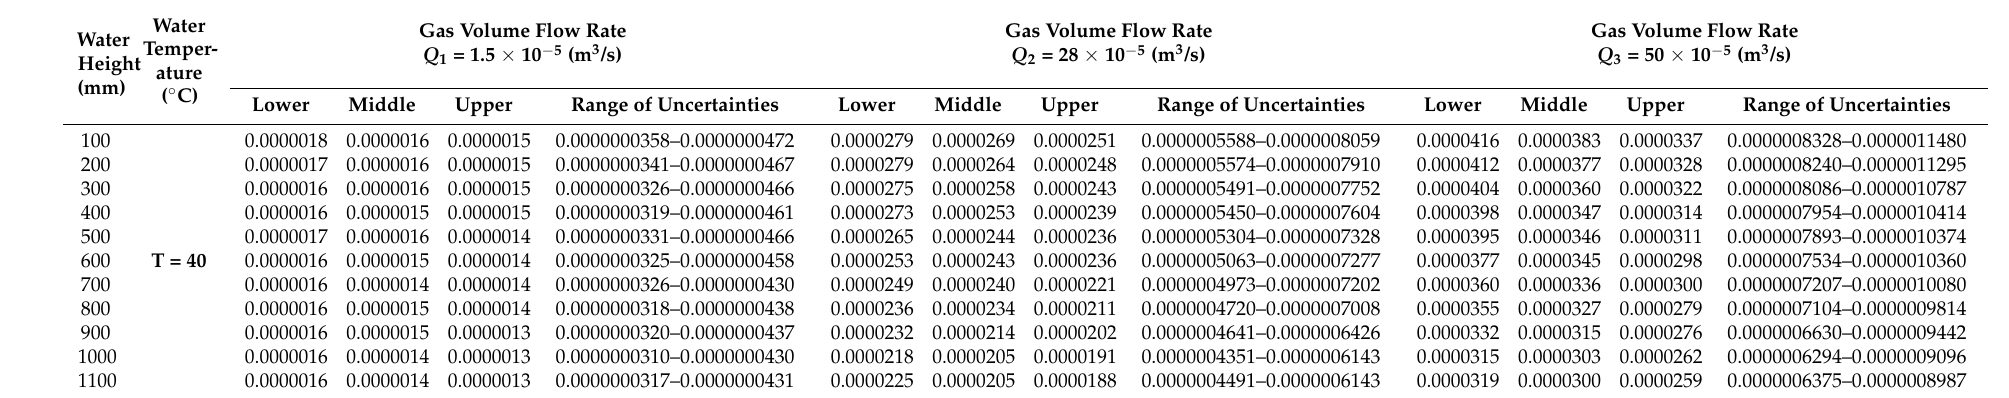
Table 12. Void fraction α as a function of water height for a water temperature of 40 ◦ C and for gas volume flow rates Q1–Q3 .